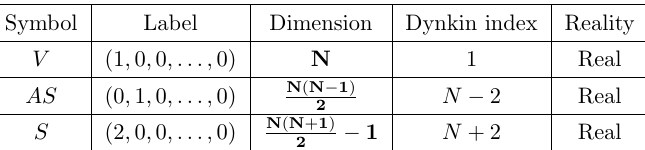
Table 17 . Various group theory data for SO( N ) representations associated with tensors with at most two indices. Here the label entry stands for the standard Dynkin label of the representation, and the symbol entry provides the shorthand symbol that will be employed for that representation throughout this article. Additionally, the dimension, Dynkin index and the reality properties of the representation are